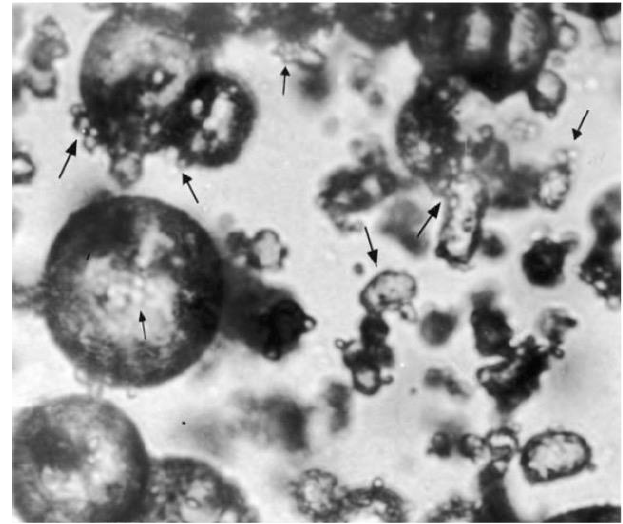
Figure 6. Microdroplets of vegetation water and solid particles observed with a light microscope at a magnification of 600 in newly produced olive oil (the arrows show the locations of microorganisms). Reprinted from Food Microbiology, Vol 19, Issue 1, Survival of micro-organisms in extra virgin olive oil during storage, Pages No. 105–109, Copyright (2002) with permission from Elsevier [114].